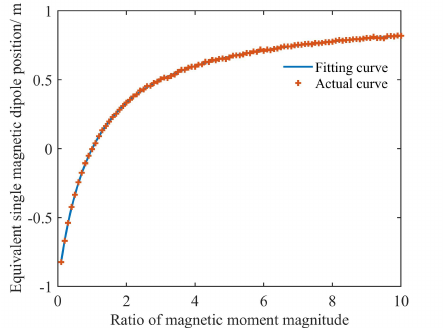
Figure 5. The relationship between the position of the equivalent single magnetic dipole and the ratio of the magnetic moment of two magnetic